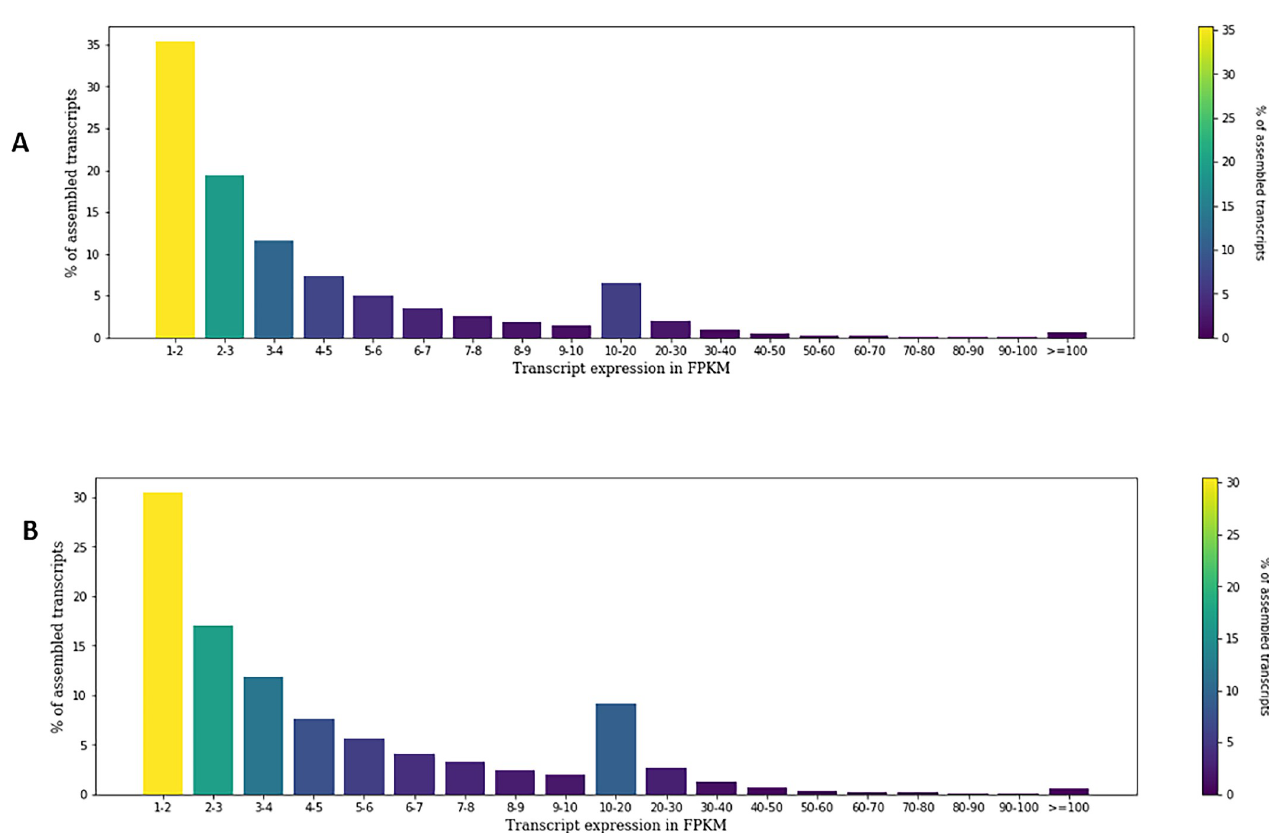
Fig 2. Transcript expression distribution of (A) unstressed and (B) anhydrobiotic H . indica IJ.